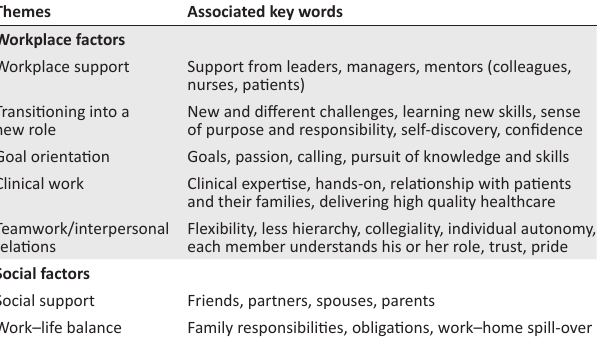
TABLE 1: Contextual factors affecting thriving at work for women and